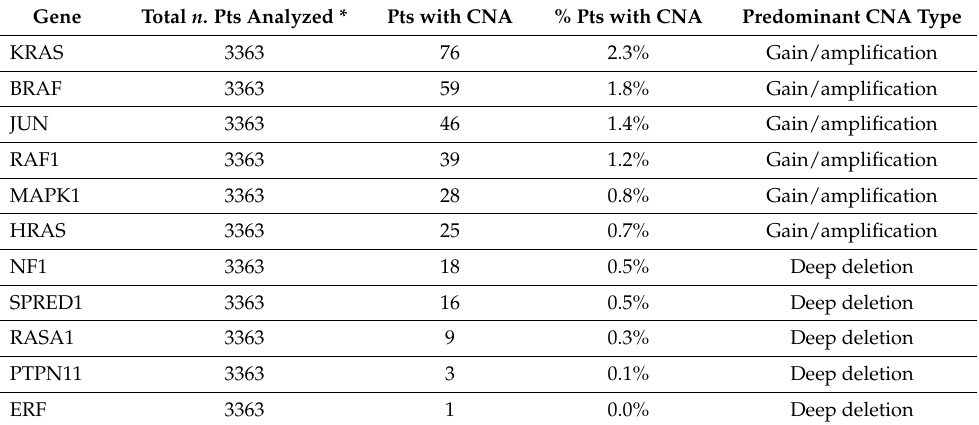
Table 4. Copy number alterations of RAS/RAF/MEK/ERK pathway genes in primary breast carci- noma samples of 3363 patients from three studies (METABRIC, TCGA, CPTAC).